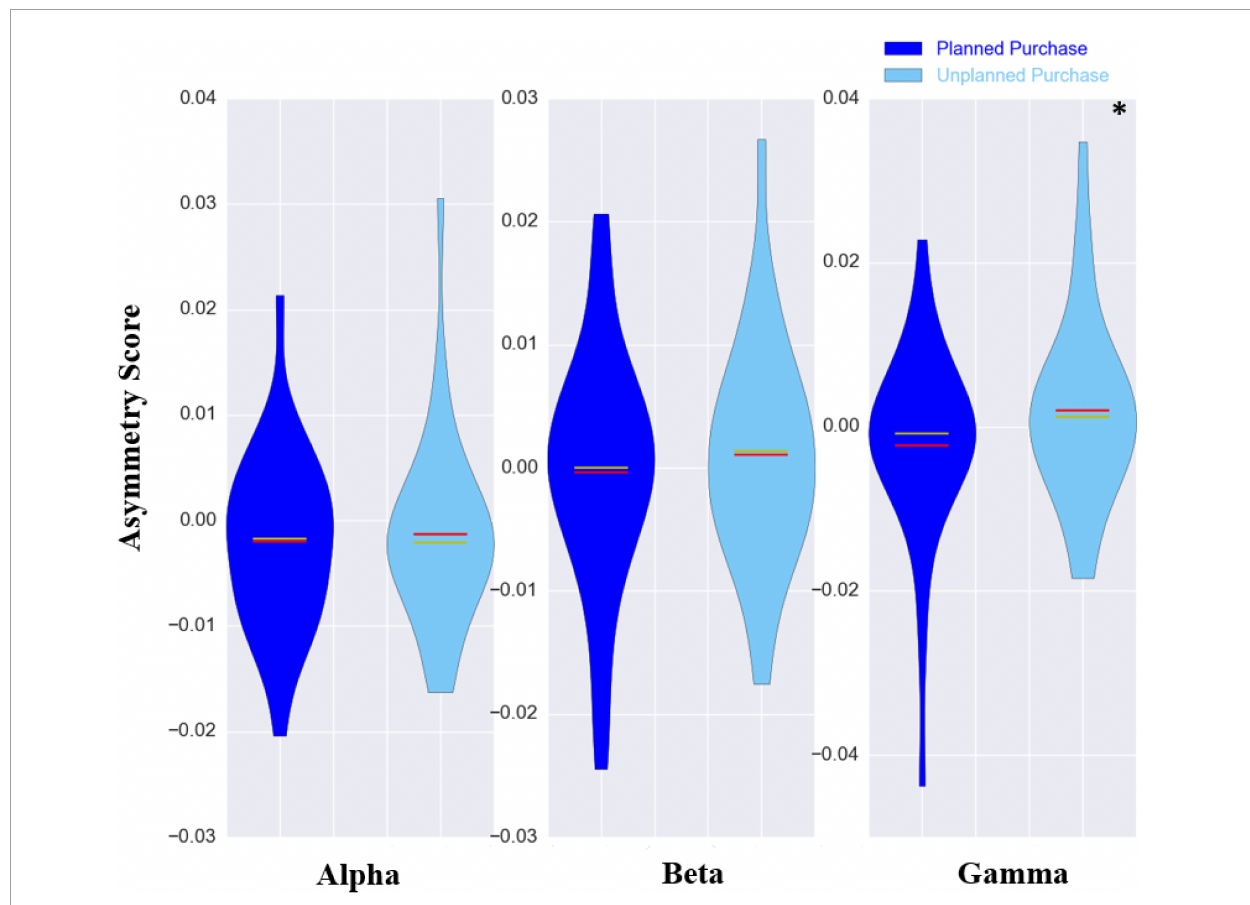
FIGURE5 The violin plots of asymmetry scores of three frequency bands for all subjects. The planned purchase and unplanned purchase conditions are shown with dark-blue and light-blue colors, respectively. The red and yellow line in the middle illustrating the mean and median values, respectively. The difference between the asymmetry scores was statistically significant ( ∗ p -value < 0.001) in gamma frequency